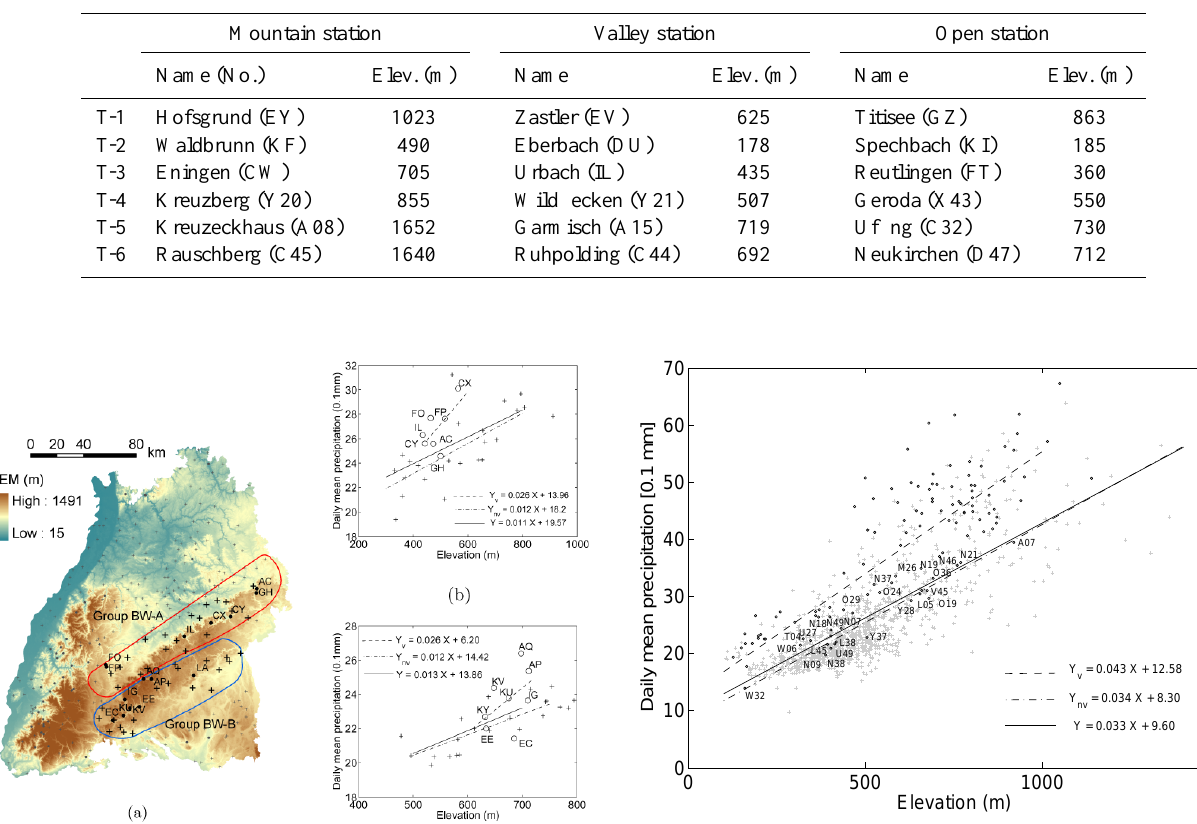
Table 3. Selected stations triples for statistical analysis.